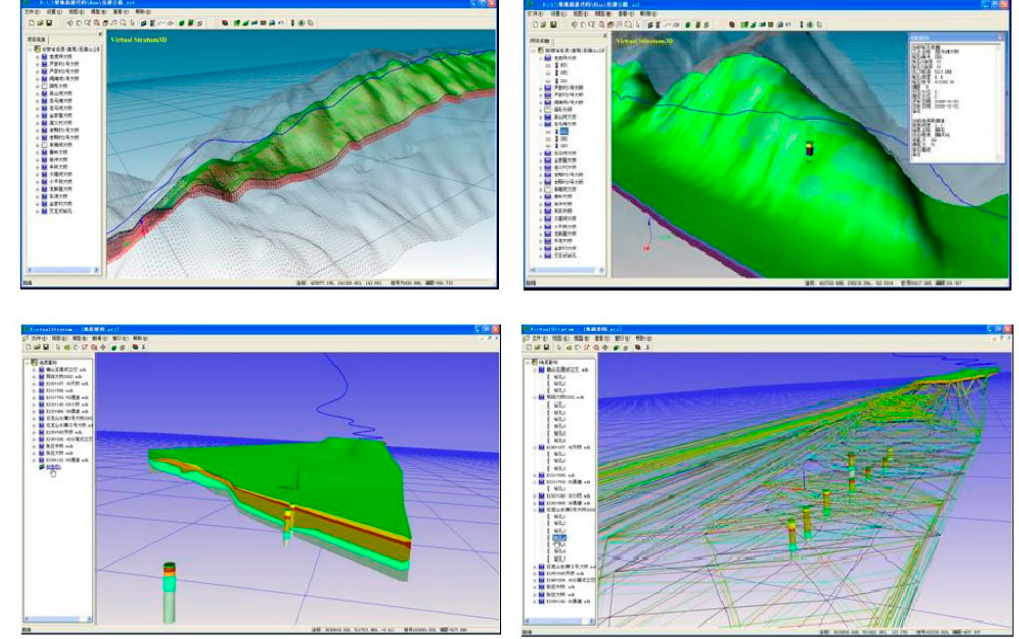
Figure 7. An example of geological analysis.